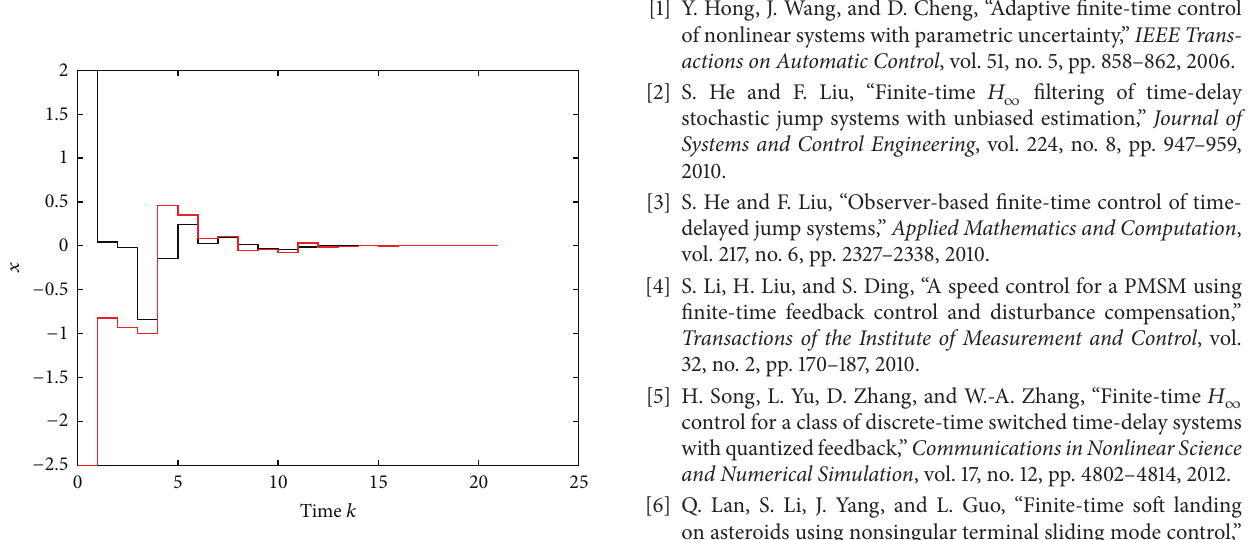
Figure 3: 𝑥(𝑘) of closed-loop